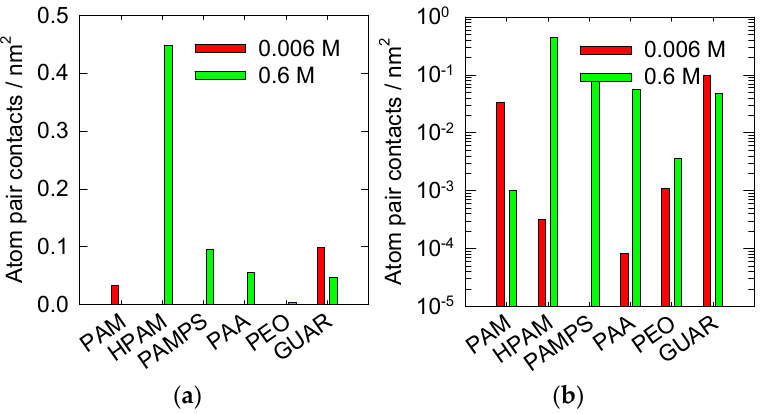
Figure 1. Surface contact between pairs of polymer atoms and the kaolinite surface (010) at pH 7 at 300 K and in the presence of NaCl. ( a ) Linear scale; ( b ) logarithmic scale. Adsorption at a low salt concentration mainly occurs with PAM and GUAR, with values of 0.04 and 0.1 nm − 2 , respectively. When no salts are present, neutral polymers are more likely to be adsorbed on the surface. However, in the case of PEO, this does not